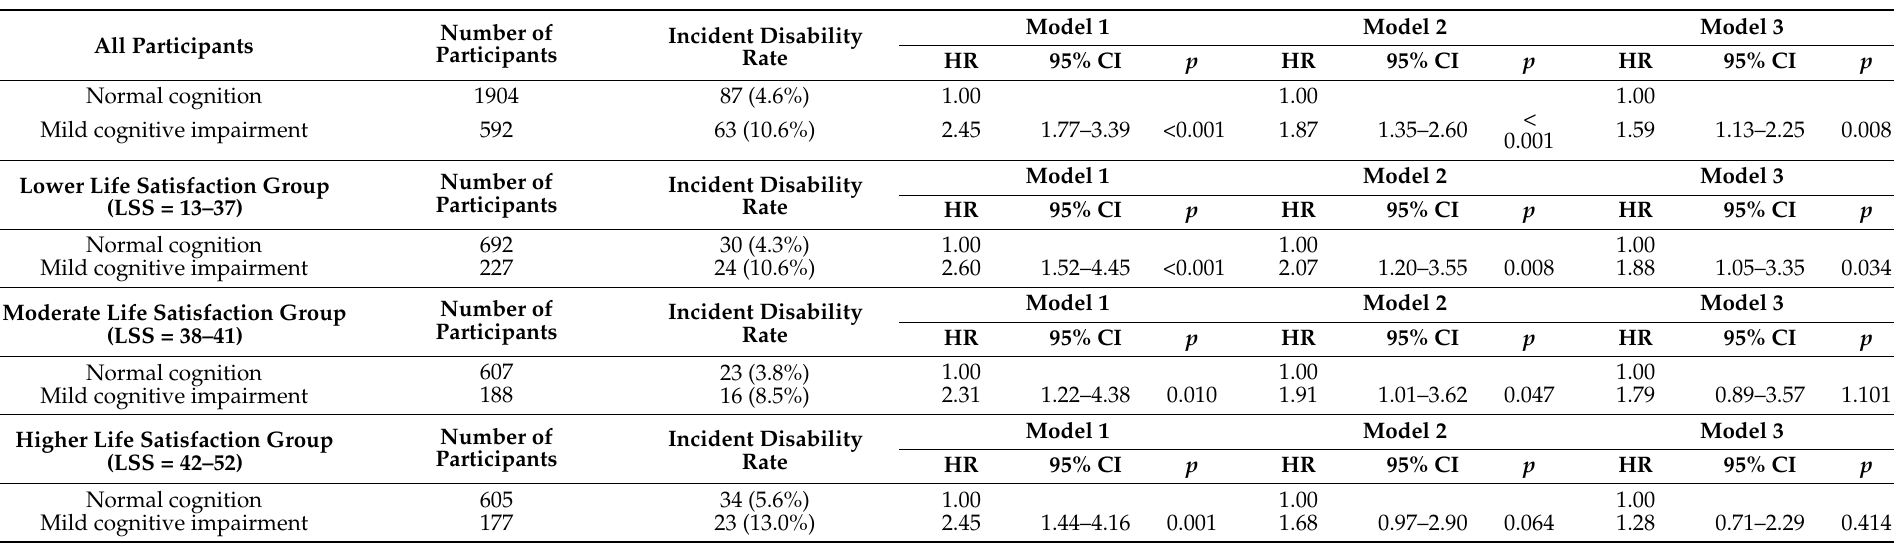
Table 3. Cox proportional hazard models of the relationships between cognitive status and incident disability in each life satisfaction